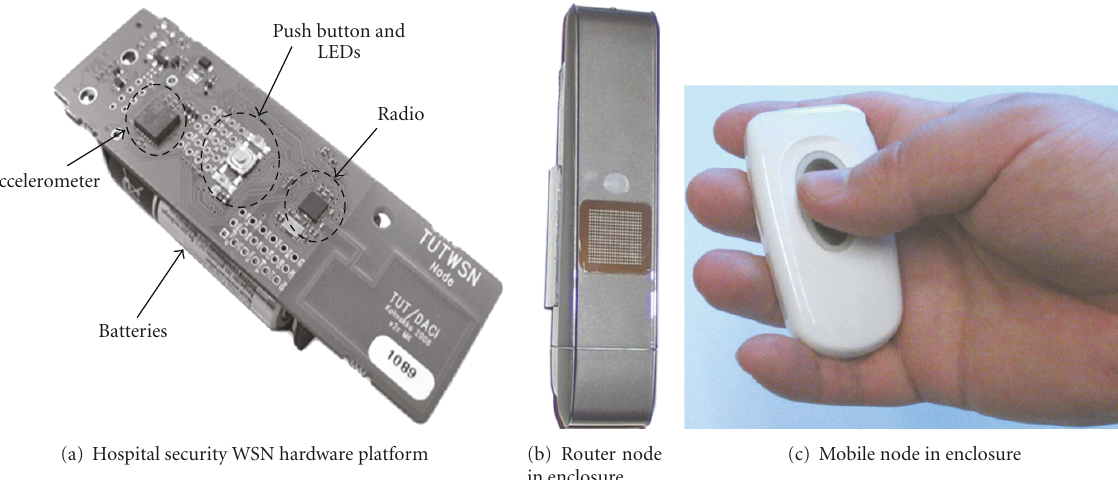
Figure 11: Hospital security WSN hardware platform and nodes in enclosure. The nodes are equipped with push button and LEDs for user interface implementation. For example in the mobile node, alarms are triggered using a push button and LEDs indicate if the alarm is on and if help is on its way. The nodes also include various sensors and on/o ff actuator control.